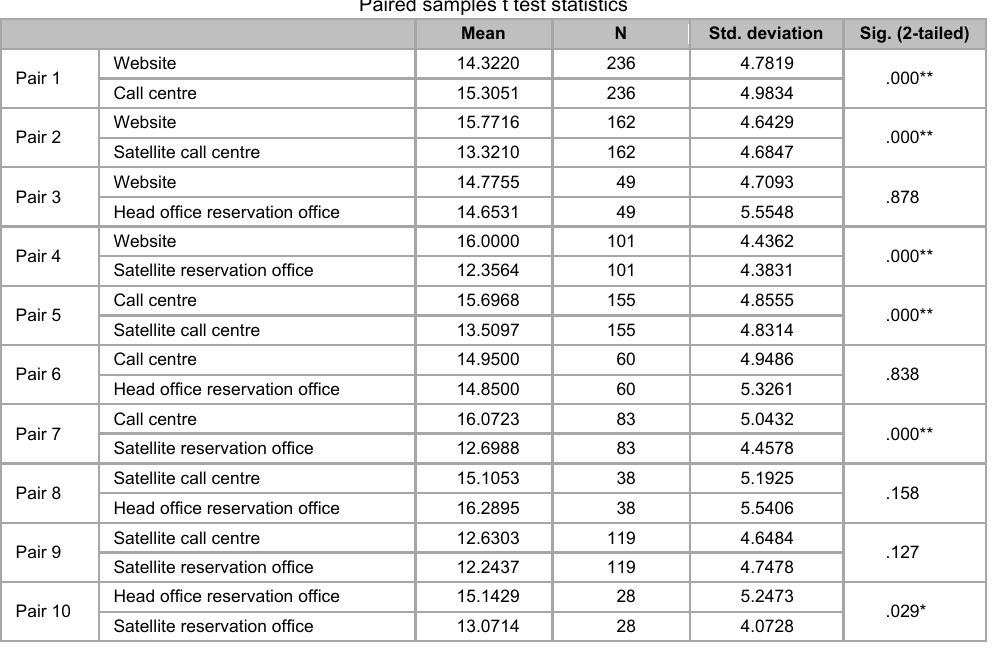
Paired samples t test